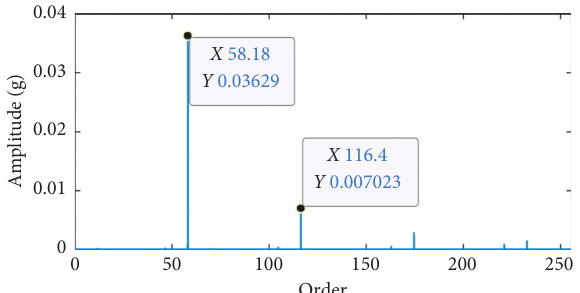
Figure 27: The envelope order spectrum of outer race fault using GRM-CS.